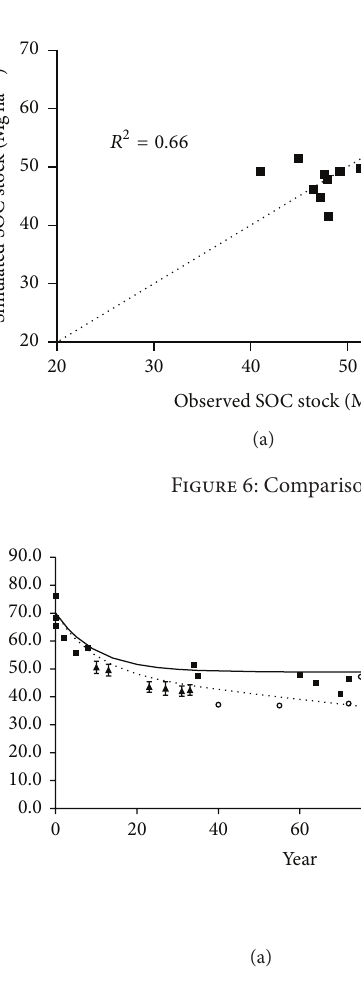
Figure 7: SOC (a) and SON (b) mean evolution during the T period of sites at 2500 Mg soilha −1 (solid line) and < 2500 Mgsoilha −1 (dotted line).